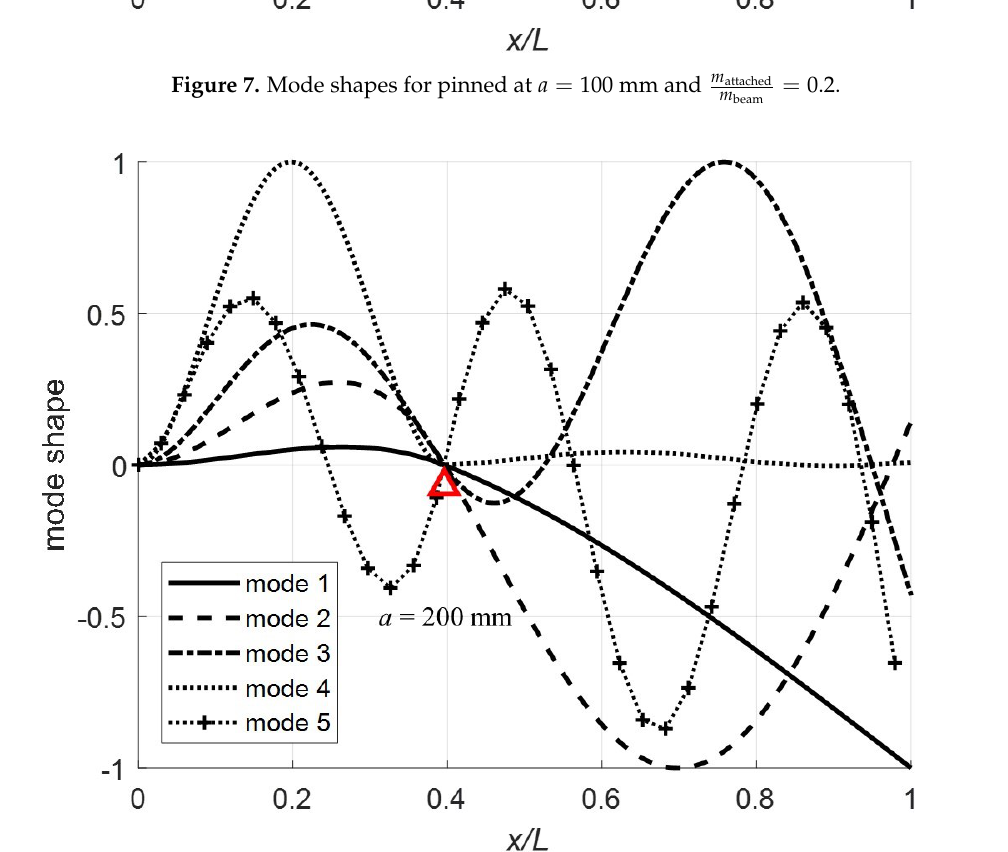
Figure 8. Mode shapes for pinned at a = 200 mm and m attached